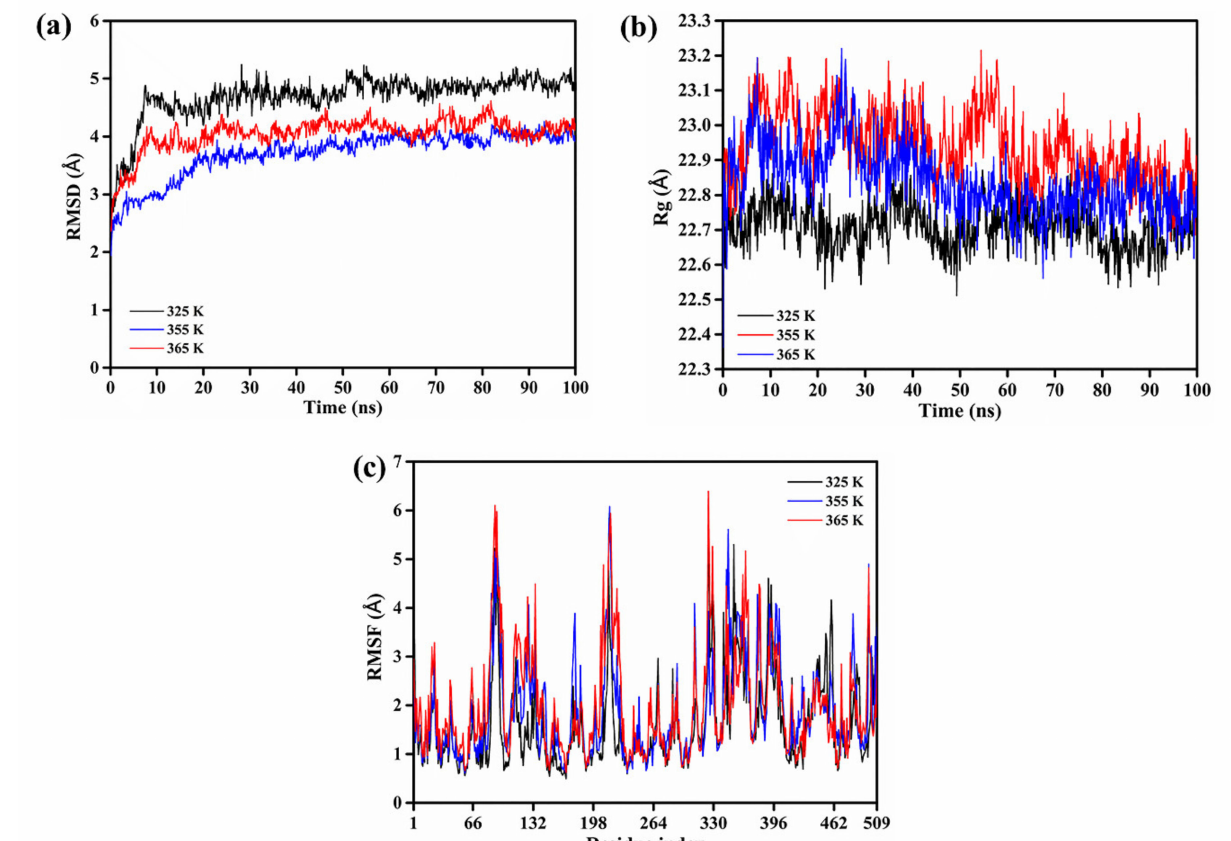
Figure 3. RMSD ( a ) and Rg ( b ) of rLAC binding with ABTS as a function of time (100 ns) at differing temperatures (325 K, 355 K, and 365 K); RMSF ( c ) value of each residue in rLAC-ABTS complex at differing temperatures after MD